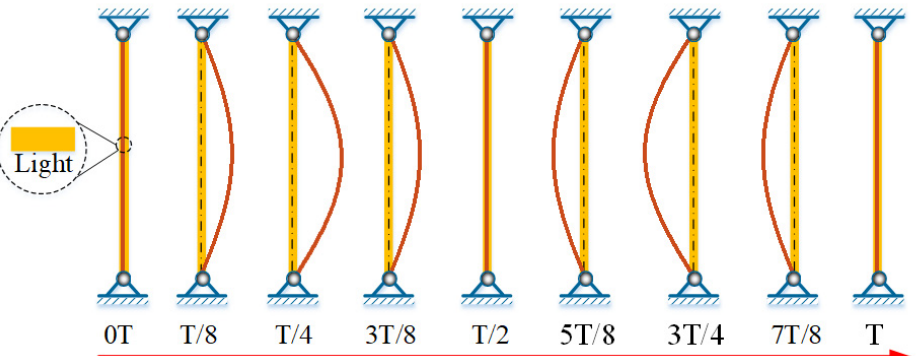
Figure 5. The snapshots in one cycle of self-sustained Euler buckling for the LCE rod shown in Figure 3c,d. The LCE rod under steady illumination self-sustained Euler buckles periodically and alternating due to the periodically varying light-induced expansion.